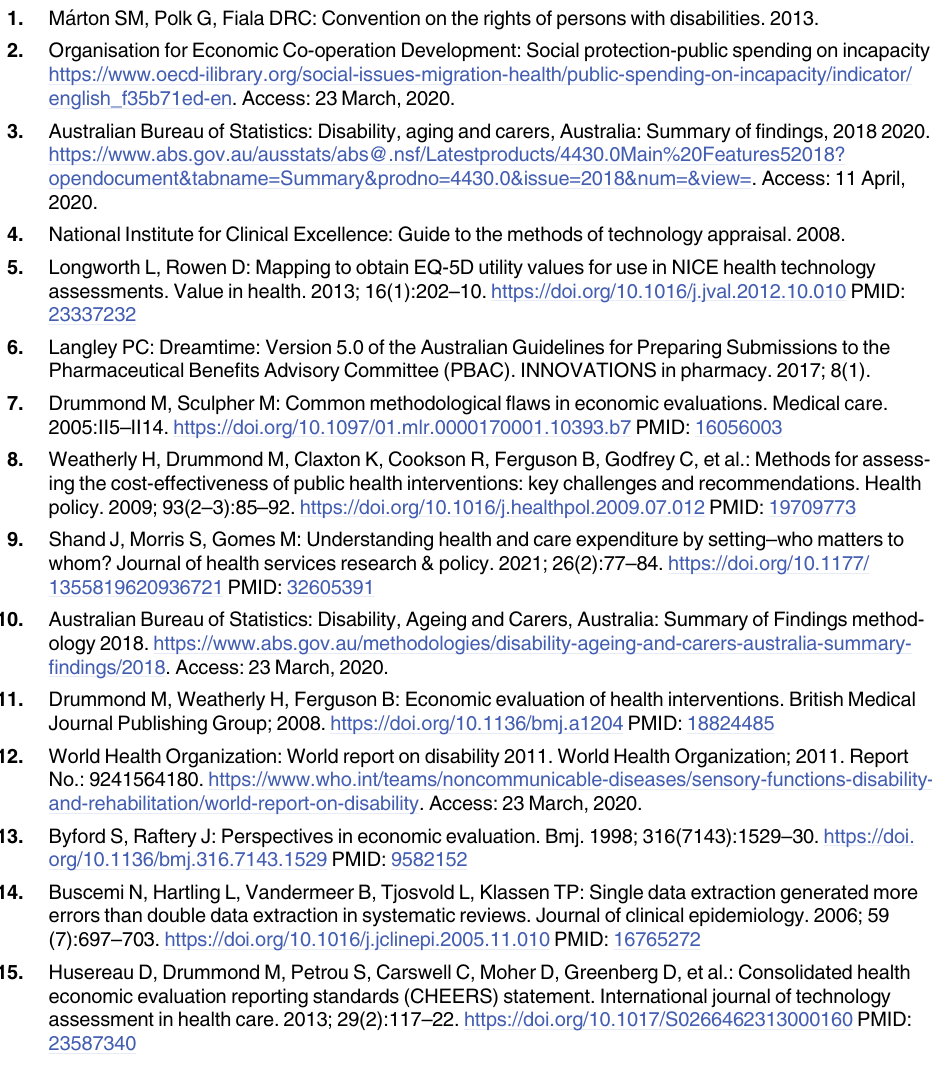
S2 Table. Number of studies assessed on reporting quality against the CHEERS